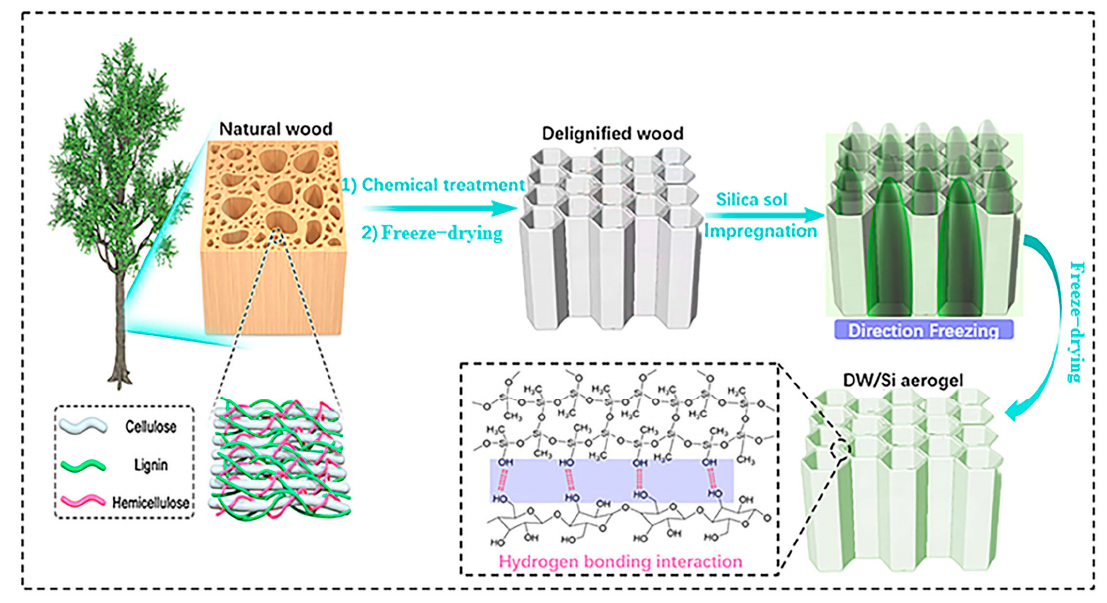
Figure 1. Schematic of the fabrication of wood-based composite aerogels via the directional − freez- Figure ing − assisted in situ sol − gel strategy.